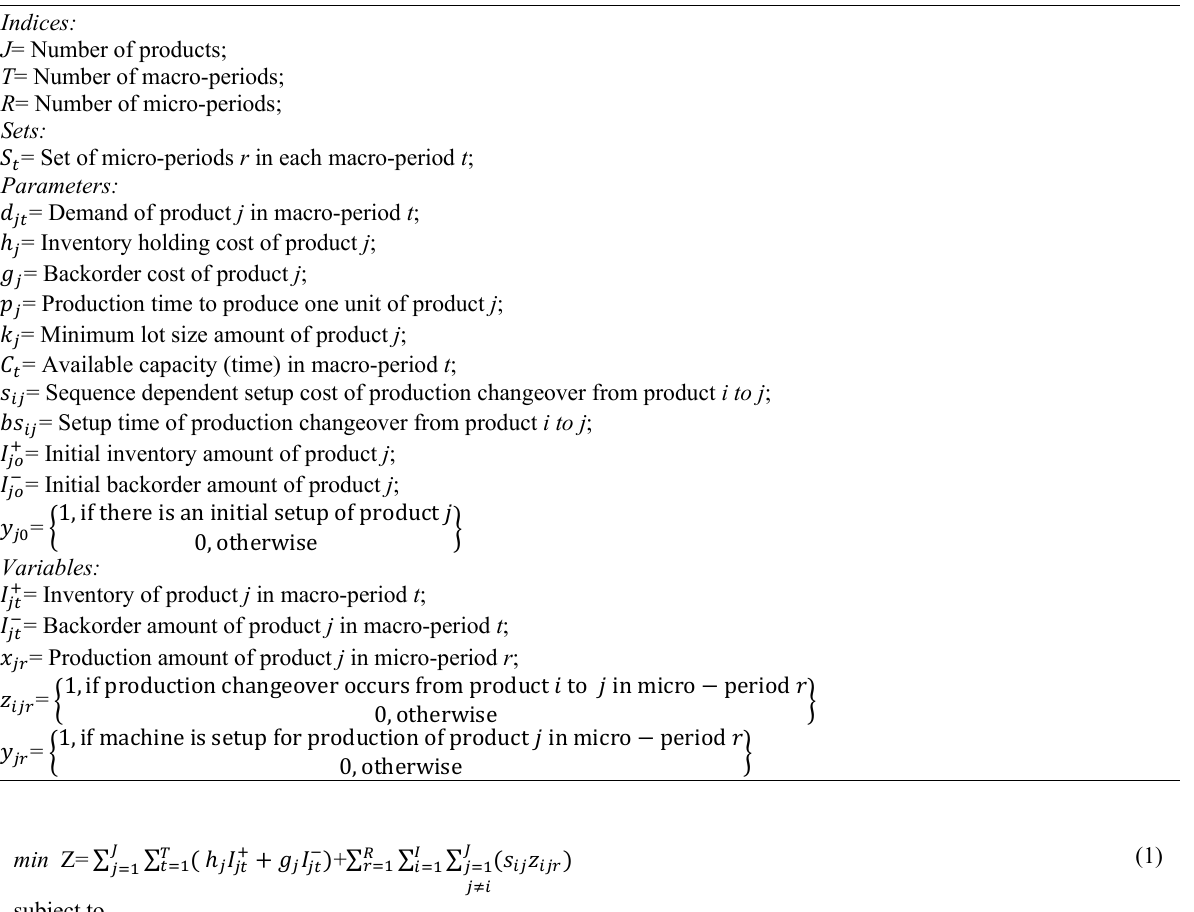
Indices, parameters and variables that are used in the GLSP